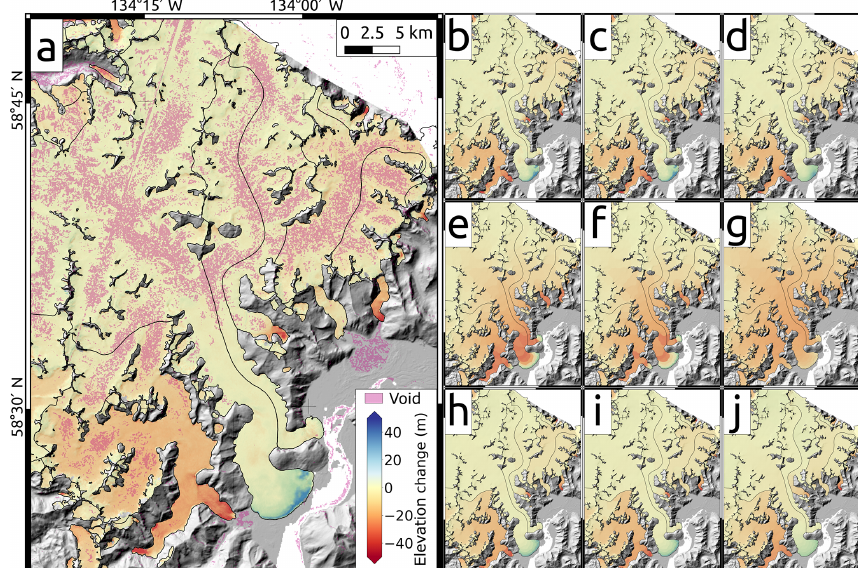
Figure 6. Elevation change maps for Juneau Icefield and Taku Glacier. (a) Initial, non-voided elevation change; (b) linear interpolation of elevation change; (c) linear interpolation of elevation; (d) 1km average; (e) global mean hypsometric; (f) global median hypsometric; (g) global polynomial hypsometric; (h) local mean hypsometric; (i) local median hypsometric; (j) local polynomial hypsometric. Note that the global interpolation schemes in panels (e) – (g) show primarily surface lowering, in contrast to the actual signal of no change or surface increase, as well as increased notability of individual glacier outlines in panels (h) – (j) .